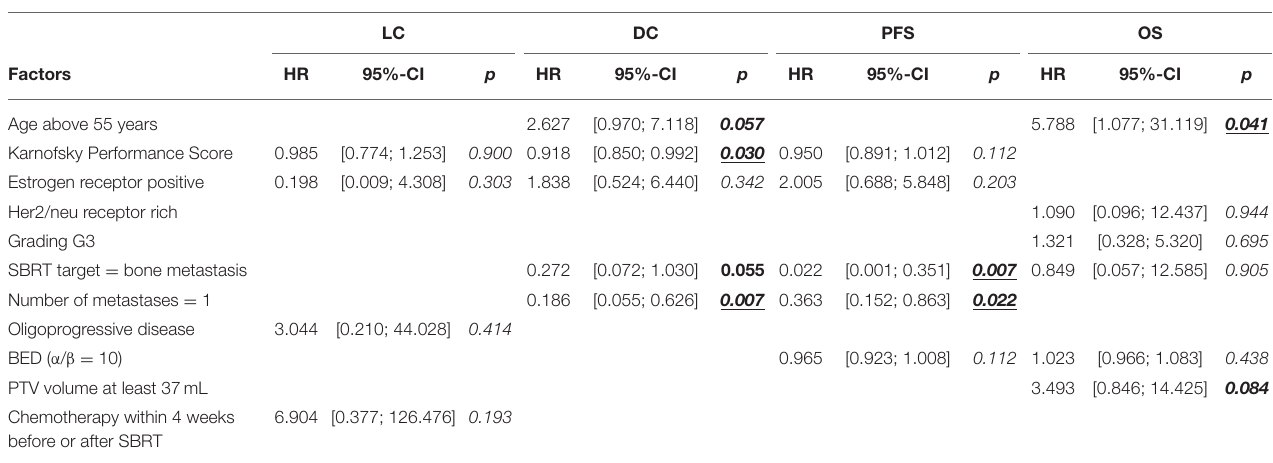
TABLE 5 | Multivariate analysis of prognostic factors influencing LC, DC, PFS, and OS. LC